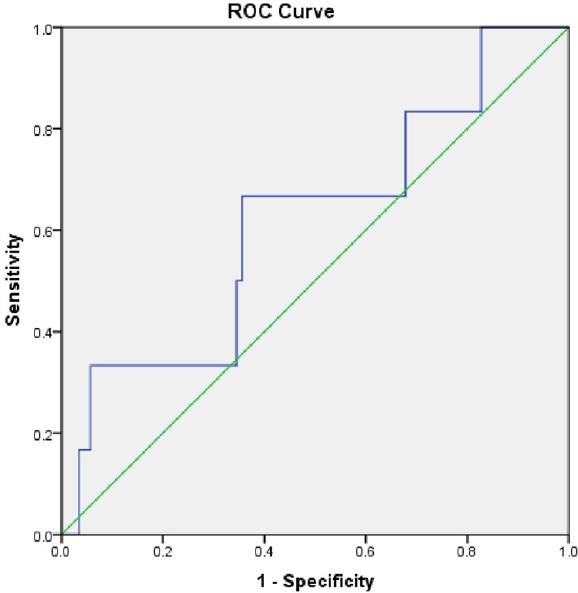
Figure 4. Receiver operator curve of Pro BNP. X-axis is sensitivity or True positive. Y-axis is 1-specficity or True negative rate. Blue line is test performance with area under the curve of 62%. Green line is when test can’t differentiate true positive from true negative as chances are 50% for